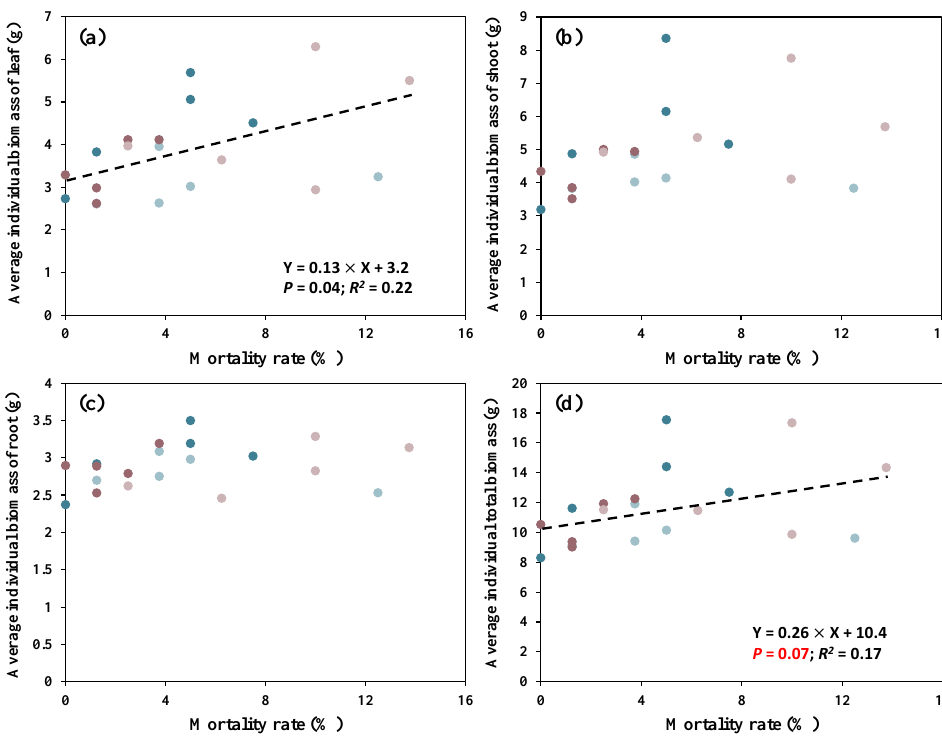
Figure 6. Relationships between the mortality rate at the end of the growing season and the average individual biomass of leaf ( a ), shoot ( b ), root ( c ), and the total biomass ( d ). Black dashed lines indicate linear relation ships between two